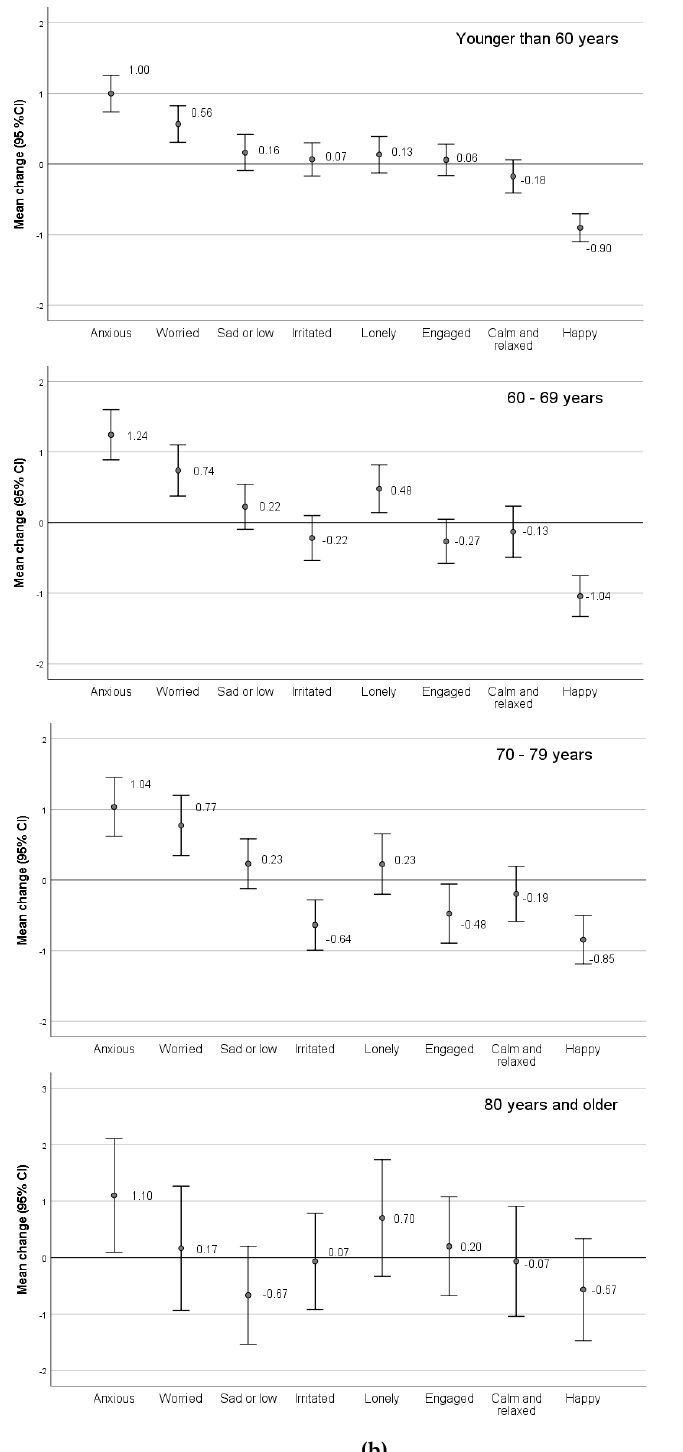
Figure 2. ( a ) Mean change in sum of emotions by age from spring 2019 to COVID-19 wave March 2020 (N = 967), range from − 30 to 50. The zero line denotes ‘no change’ in emotions; ( b ) mean change in single emotions by age from spring 2019 to COVID-19 wave March 2020 (N = 967), range from − 10 to 10. The zero line denotes ‘no change’ in